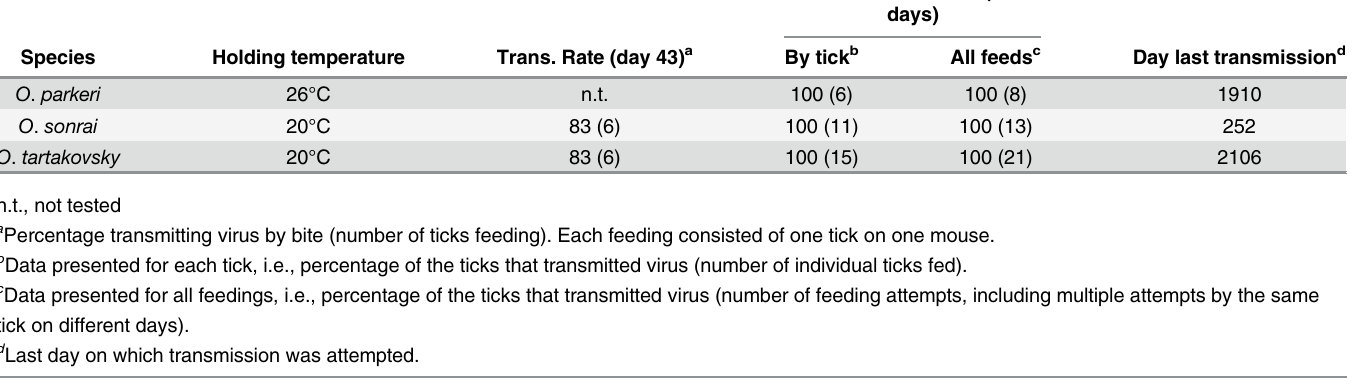
tick on different days).